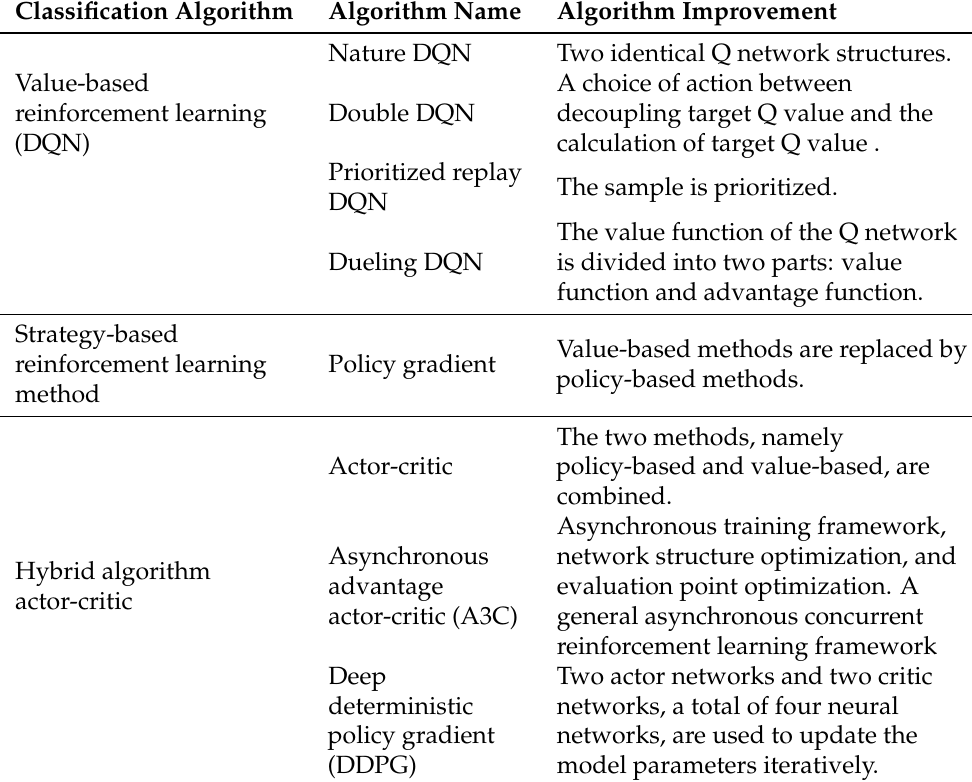
Table 1. Classical Deep reinforcement learning